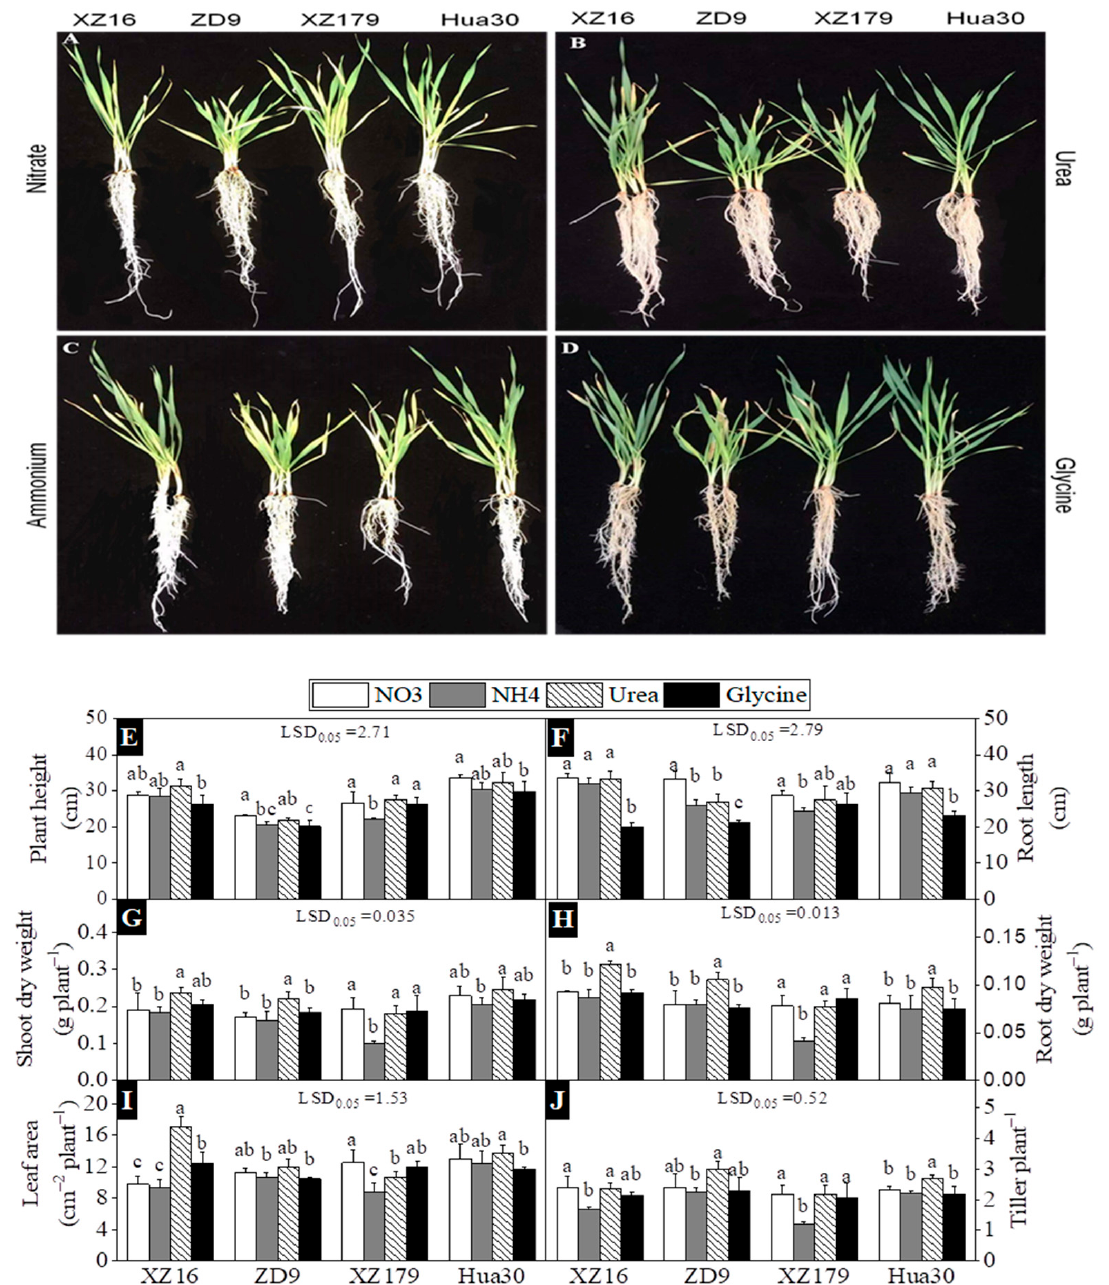
Figure 1. Effects of different nitrogen forms on plant morphology and growth parameters of four barley genotypes. ( A – D ) plant morphology after 30d of treatments (stage 4 and day 44 on Biologische Bundesanstalt, Bundessortenamt and Chemical industry scale BBCH; ( E – J ) are plant growth parameters. Values are expressed as mean ± SD ( n = 4). Significant difference ( p < 0.05) between treatments is indicated by the different letters. LSD.05 values in the figures are for the comparison between genotypes.